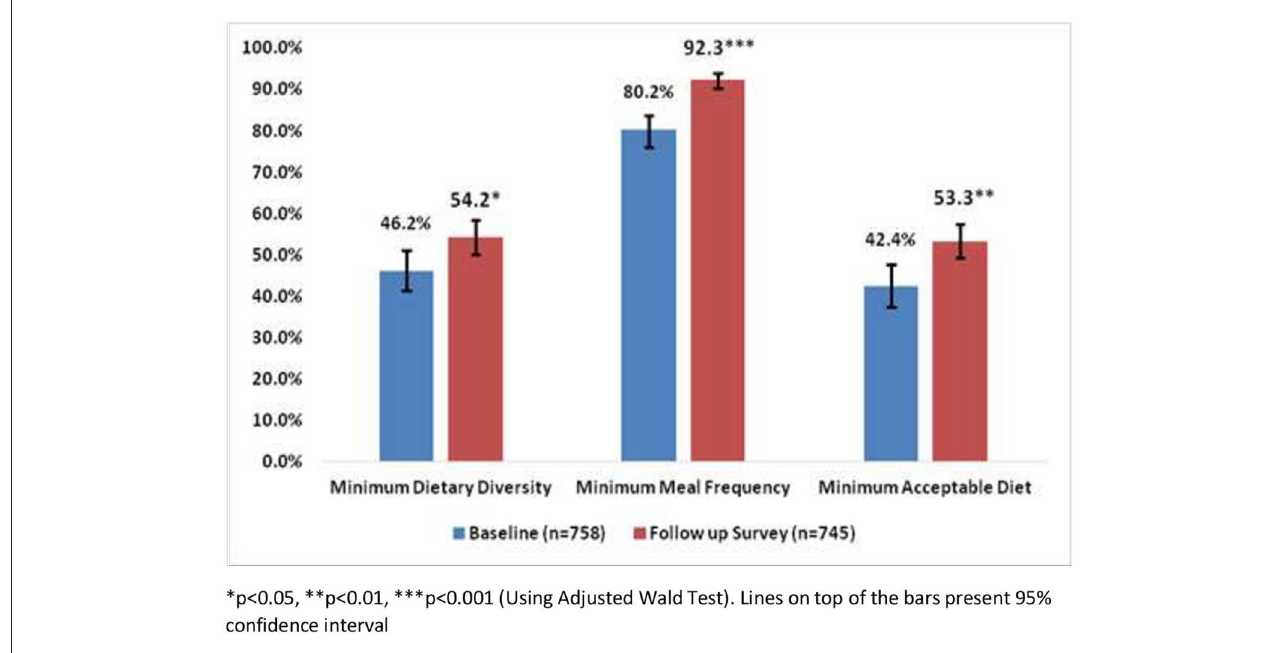
FIGURE2 Complementary feeding practices among the caregivers of children aged 6–23 months.